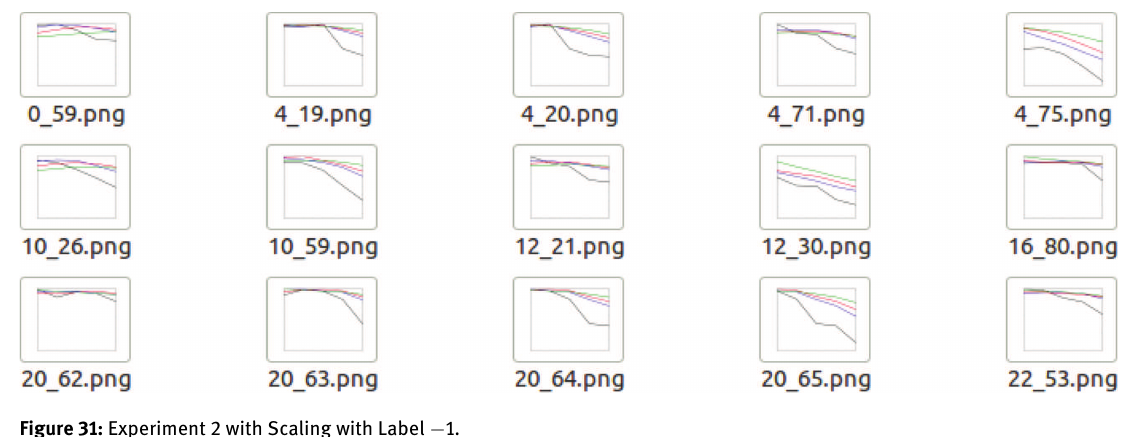
Figure 30: Experiment 2 with Scaling with Label 1.